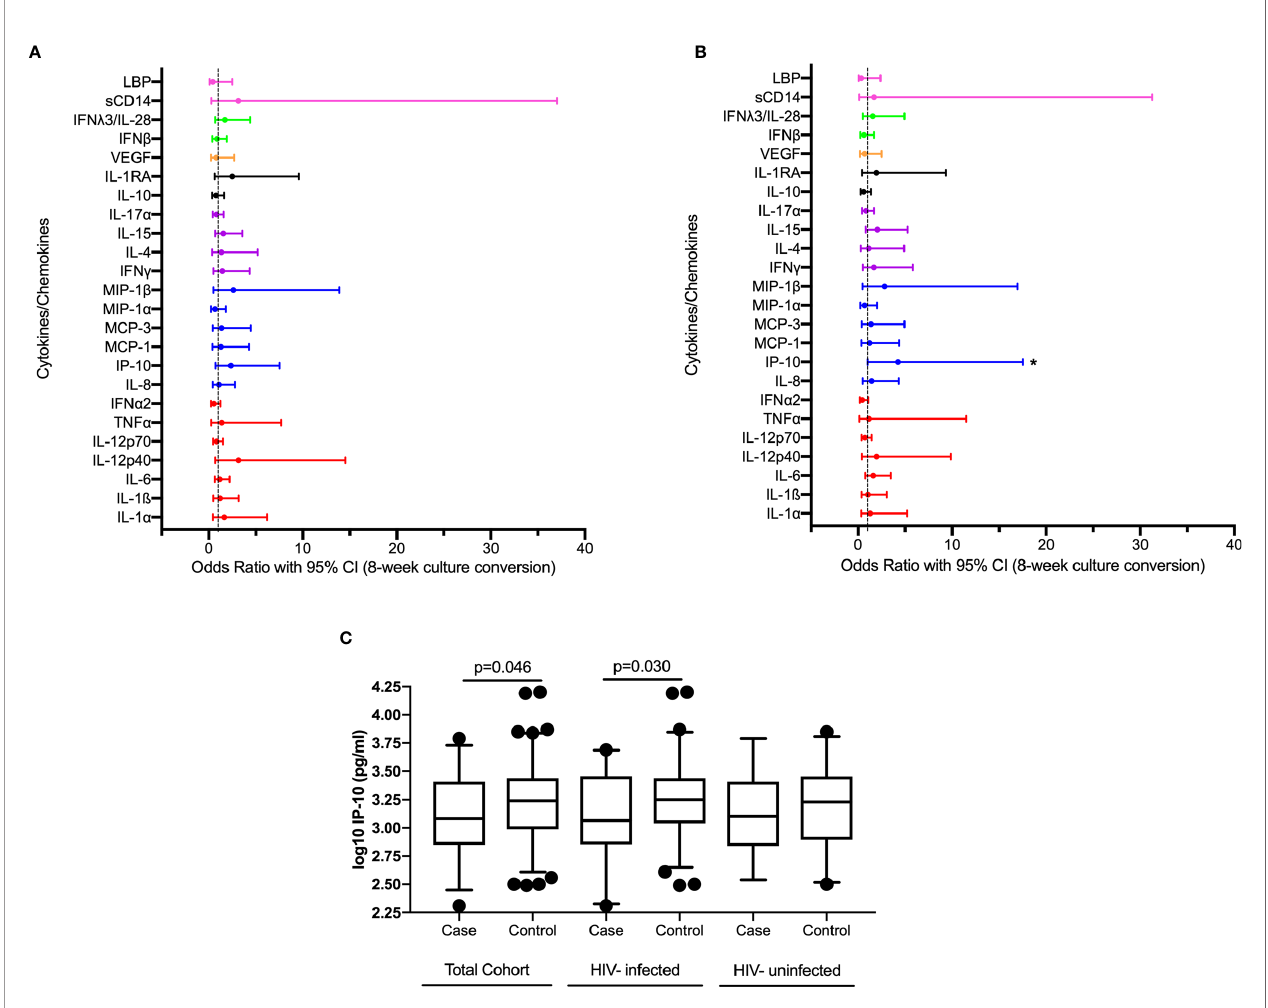
FIGURE 1 | Association between plasma cytokine/chemokine expression at active TB and 8-week culture conversion (n=132) in a (A) bivariable and (B) multivariable logistic regression model. Individual associations are shown between 8-week culture conversion and pro-in fl ammatory cytokines (red), chemokines (blue), adaptive response cytokines (purple), anti-in fl ammatory (black), growth factors (orange), interferons (green) and plasma biomarkers (pink) with error bars depicting 95% con fi dence intervals. Asterisk indicates signi fi cant association (p<0.05). (C) IP-10 expression among cases and controls in IMPRESS Cohort (cases n=31, controls n=101) and within the nested group of HIV-infected (cases n=20, controls n=76) and HIV-uninfected (cases n=11, controls n=25) individuals. Cytokines were plotted on log scale (Log 10), Box and Whiskers (5 – 95%). p-values shown on the graphs are results of the multivariable logistic